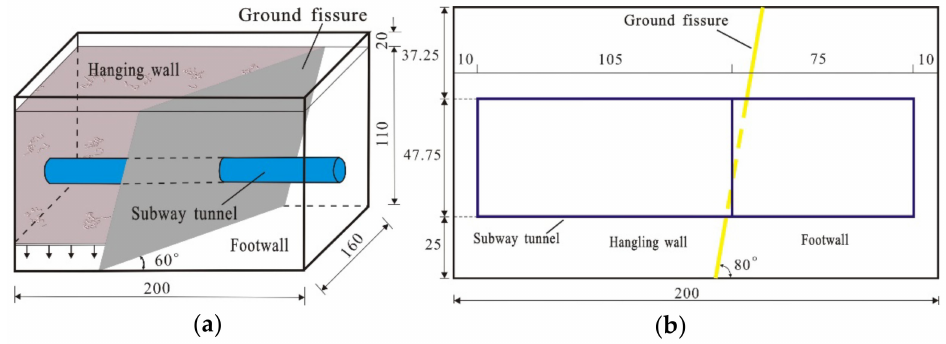
Figure 1. Test model (unit: cm): ( a ) schematic diagram of test model; ( b ) profile of the test